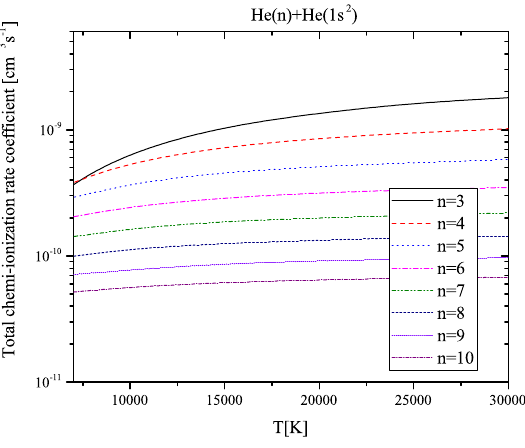
Figure 6. The plot of the K ci ( n , T ) and K cr ( n , T ) collisional ionisation He*( n ) + He(1 s 2 ) rate coefficients. That is, chemi-ionization processes (4) in the region 7000 K ≤ T ≤ 30,000 K and for principal quantum numbers 3 ≤ n ≤